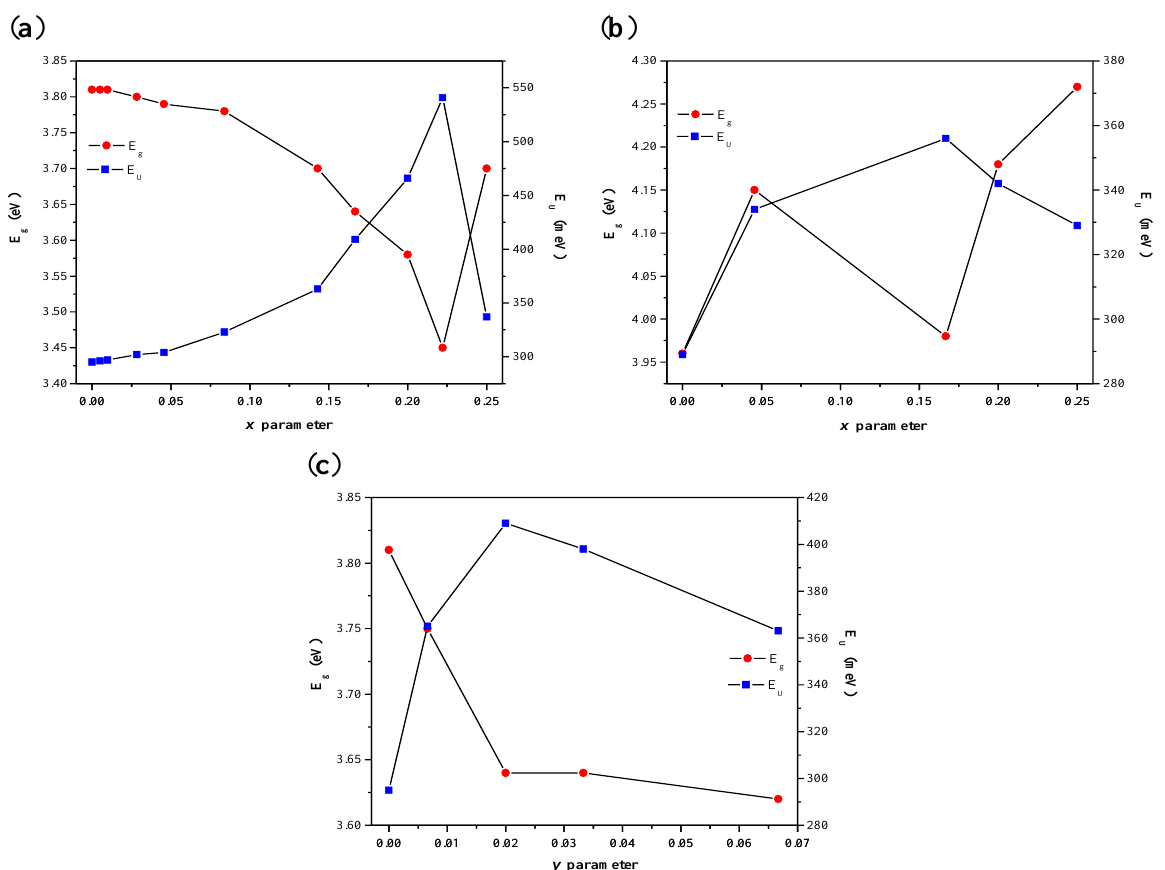
Figure 9. Variation of direct band gap ( E g ) and Urbach energy ( E U ) with Gd 3+ ( x ) or Mn 2+ ( y ) doping in CaMnGdMoWO ceramic materials obtained by solid-state reaction method ( a , c ) and combustion route ( b